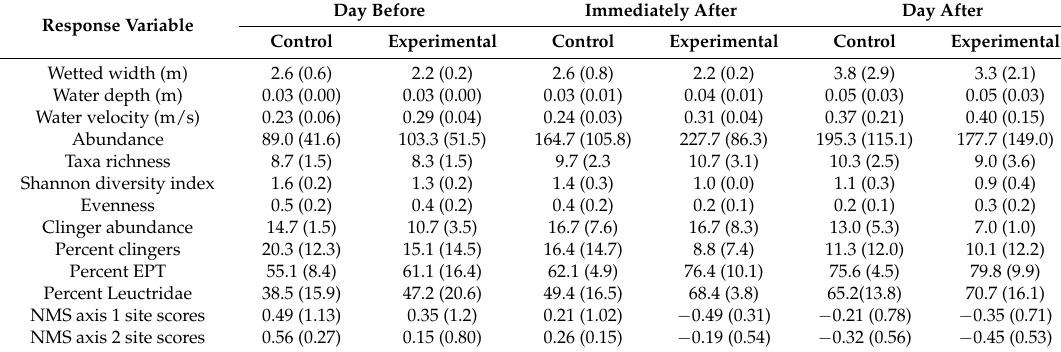
Table A3. Means (SD) of hydrologic and macroinvertebrate community response variables that did not exhibit a significant interaction effect of day (one day before, immediately after, one day after experimental disturbance) and riffle types (Control, Experimental) in riffles within three agricultural headwater streams of upper Alum Creek, 5–4 June